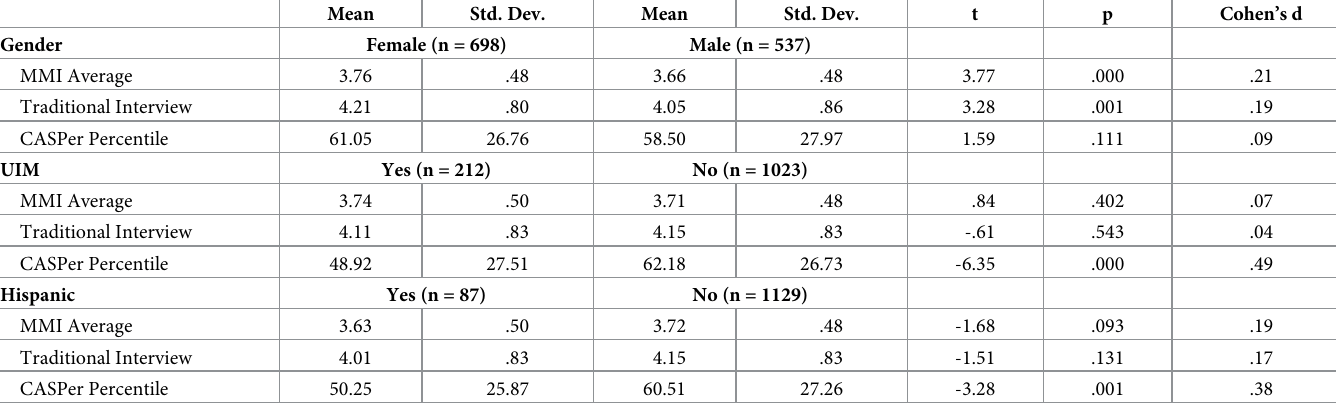
Table 2. Comparisons of MMI Score, Traditional Interview Score and CASPer